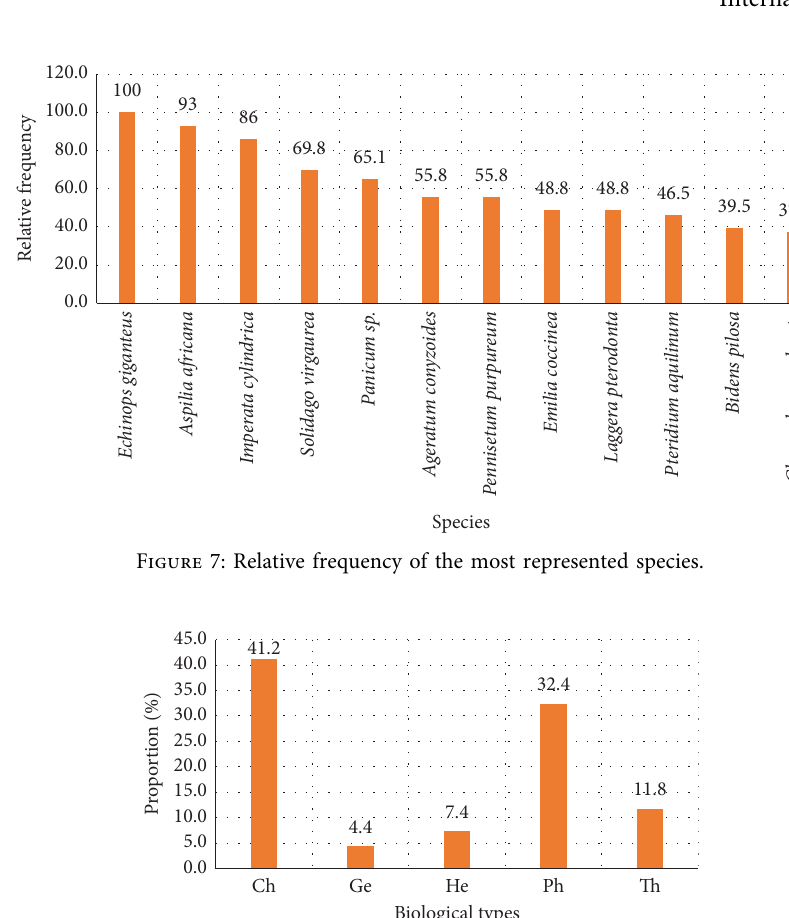
Figure 8: Proportion of biological types: ( Ch ) Chamaephytes , ( Ge ) Geophytes , ( He ) Hemicryptophytes , ( Ph ) Phanerophytes , and ( T ) Terophytes .